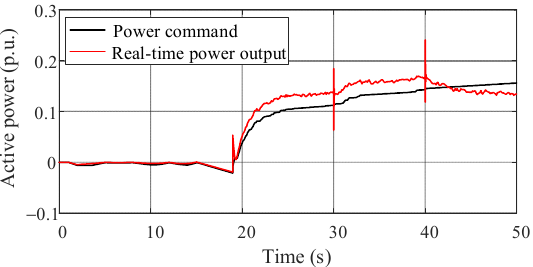
Figure 28. The power command curve and the real-time power output curve of HESS in case II.